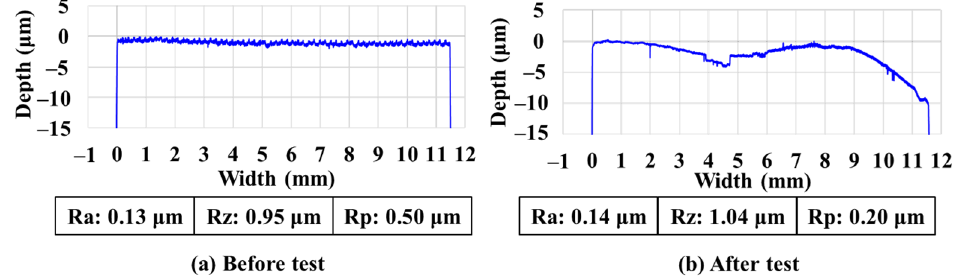
Figure 21. Bearing surface properties with a-C:H:Si-coated journal: ( a ) before test and ( b ) after test.